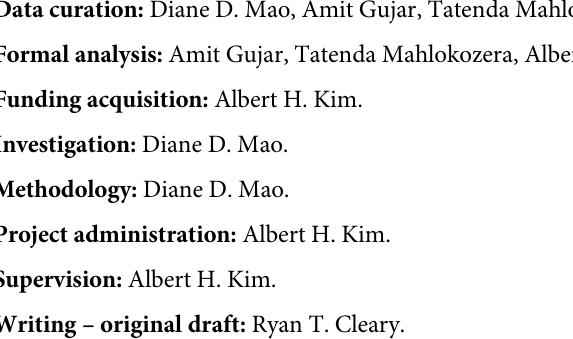
S1 Fig. CDC20 RNAi phenotypes can be rescued by co-expression of RNAi-refractory CDC20. (A) B36 GSCs transduced with CDC20 RNAi viruses as in Fig 1A were